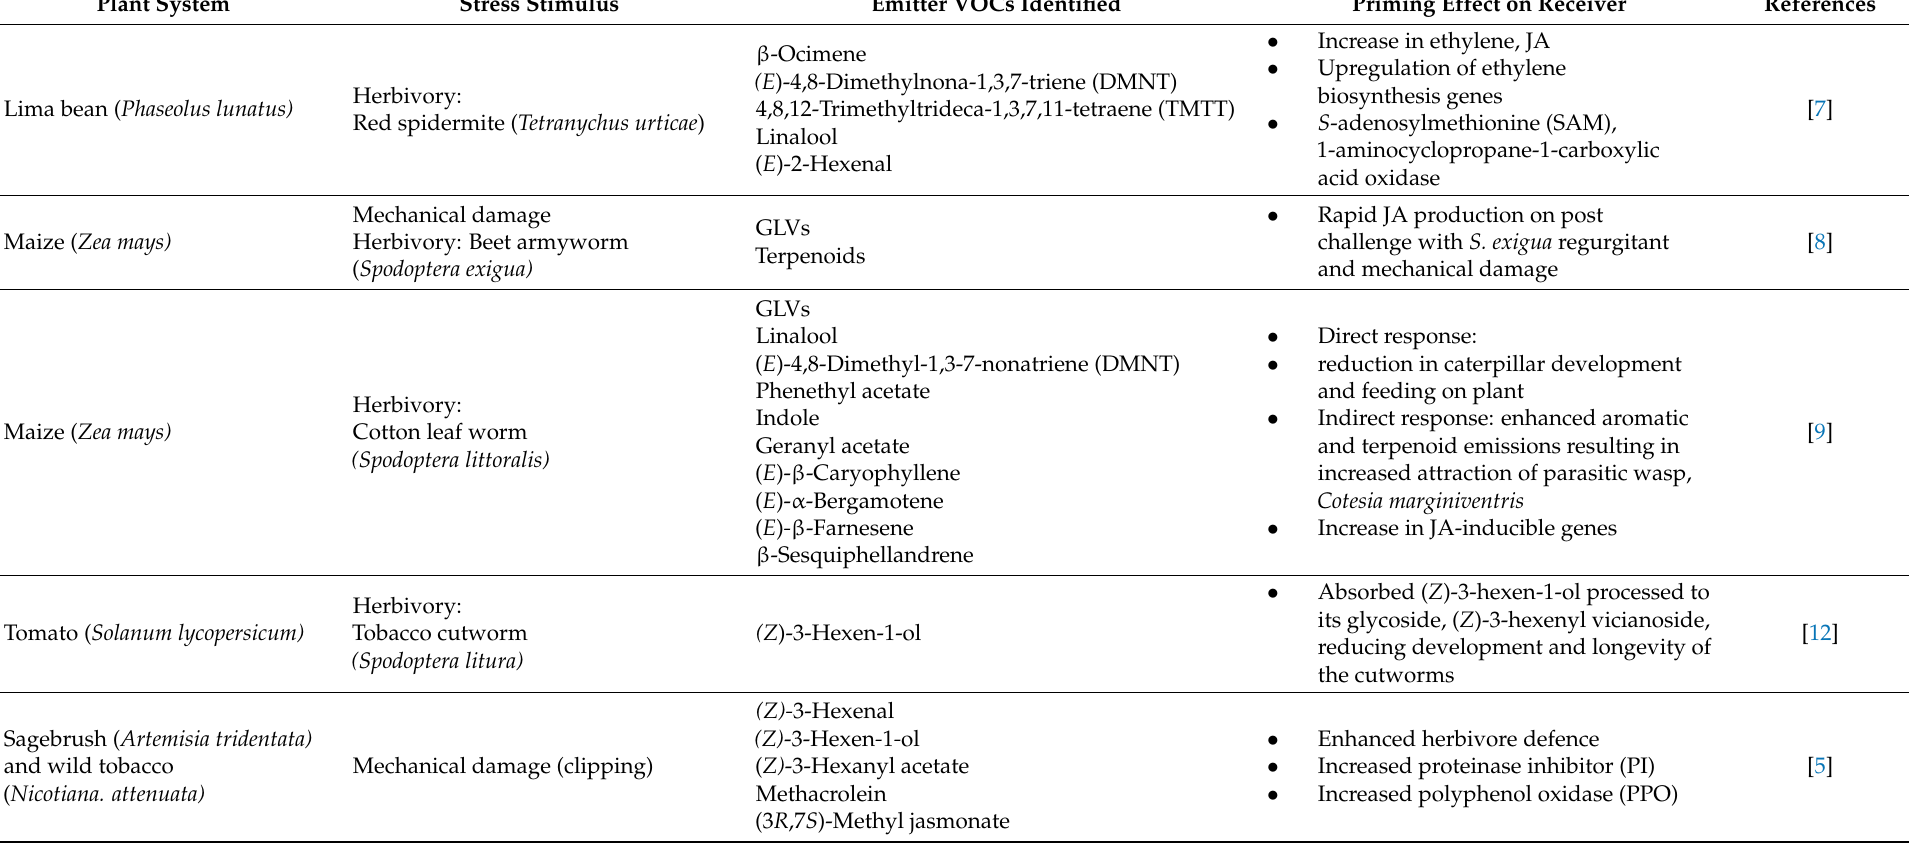
Table 1. Volatile-mediated priming in plant–plant communication under biotic and abiotic stress conditions. Plant